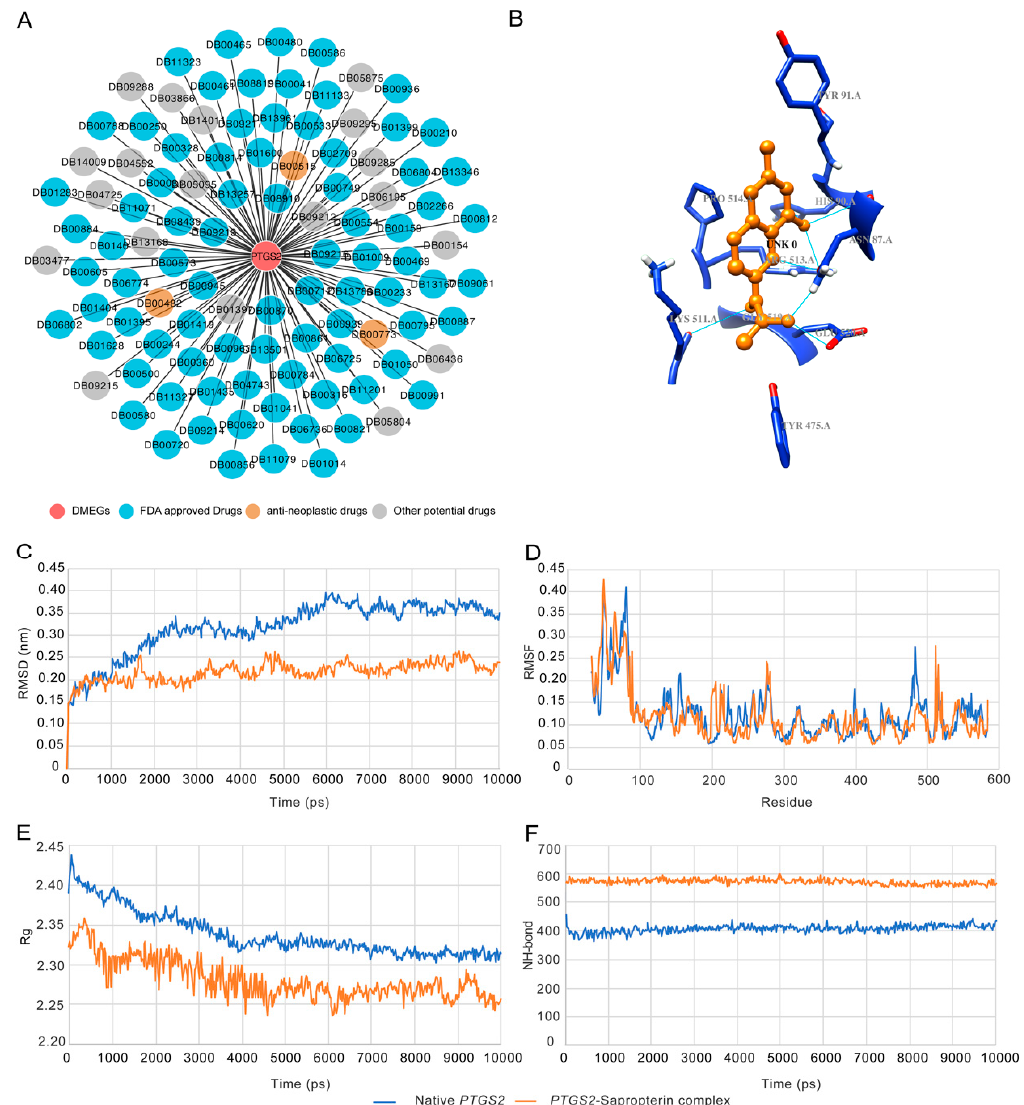
Figure 5. Example of PTGS2–sapropterin complex based on molecular dynamics simulation (MDS)